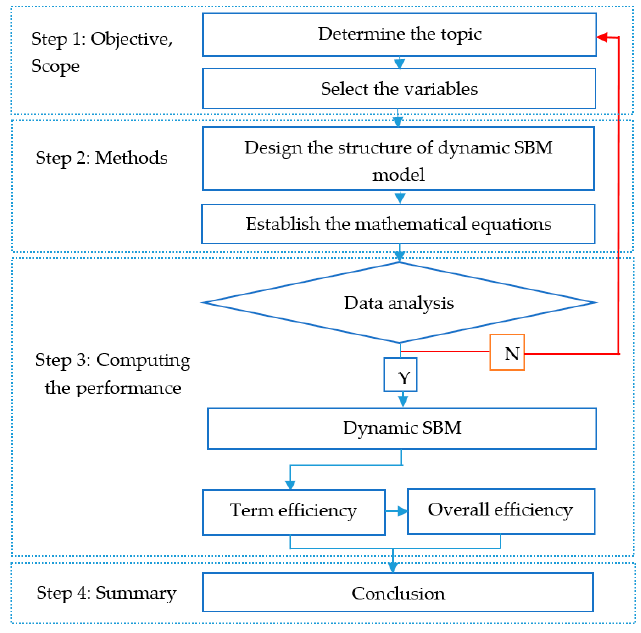
Figure 1. Research processes.